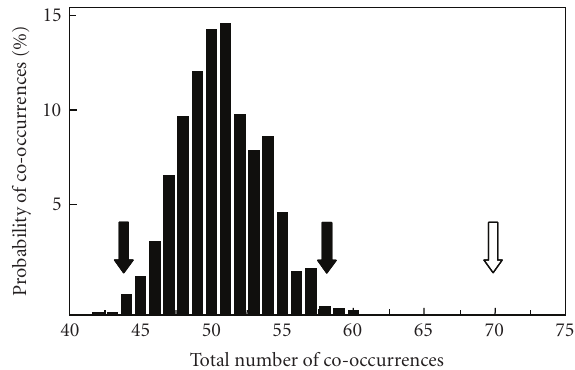
Figure 1: Results of 1000 Monte Carlo simulations for blow fly data collected from fly paper at all three alligator-decay sites. The test statistic for this simulation is the total number of co-occurrences (i.e., the number of times a species occurs on the same day in any pair of sites, summed for all species in the analyses). Closed arrows indicate the critical values at the 95.0% level. The observed total number of co-occurrences is shown with the open